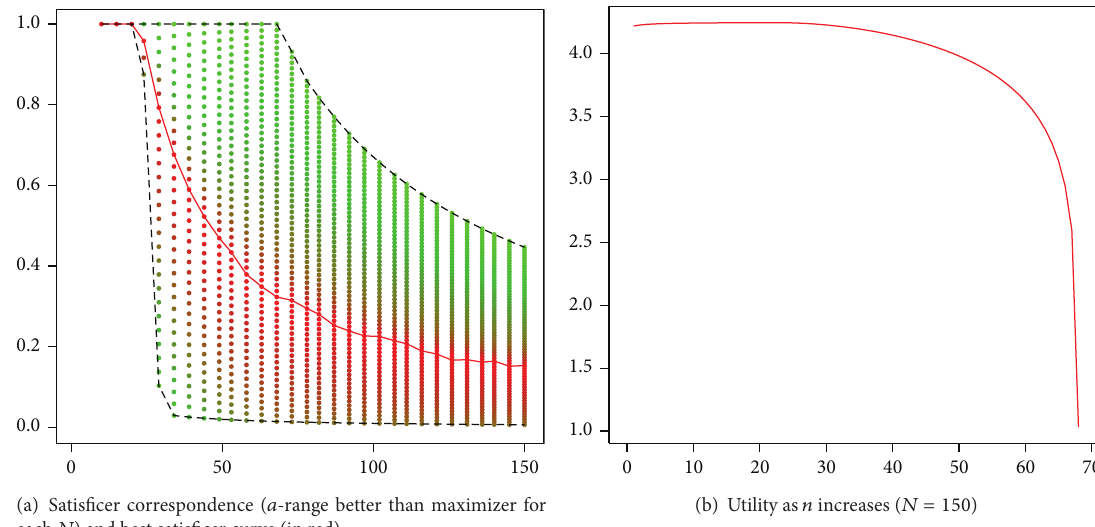
Figure 4: Satisficing behavior and welfare, case of uniform distribution with 𝜇 = 500 and 𝜎 = 50 .